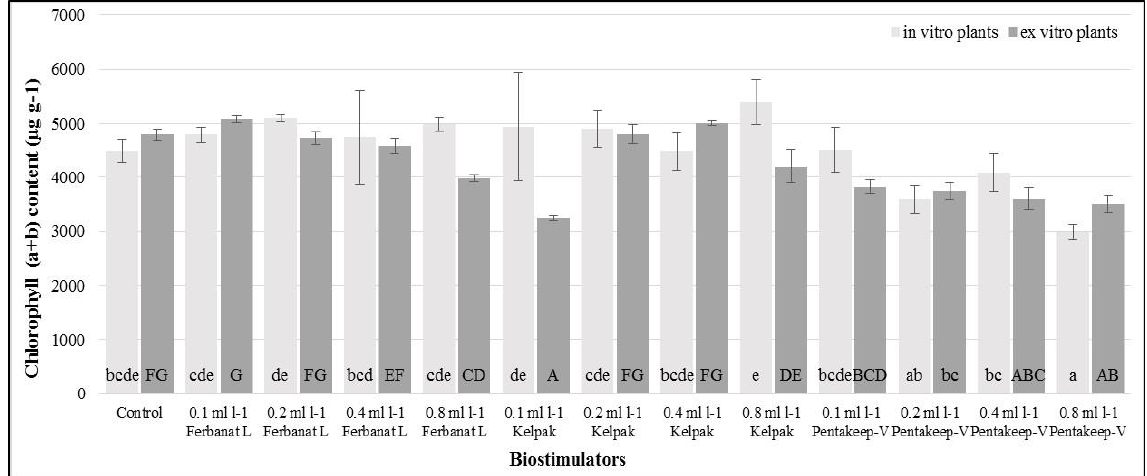
Figure 2. Chlorophyll (a+b) content of in vitro and ex vitro Hosta ’Gold Drop’ plants. Values are mean ± SD. Bars with different letter are significantly different by Tukey’s and Games-Howell’s comparison test at p≤0.05